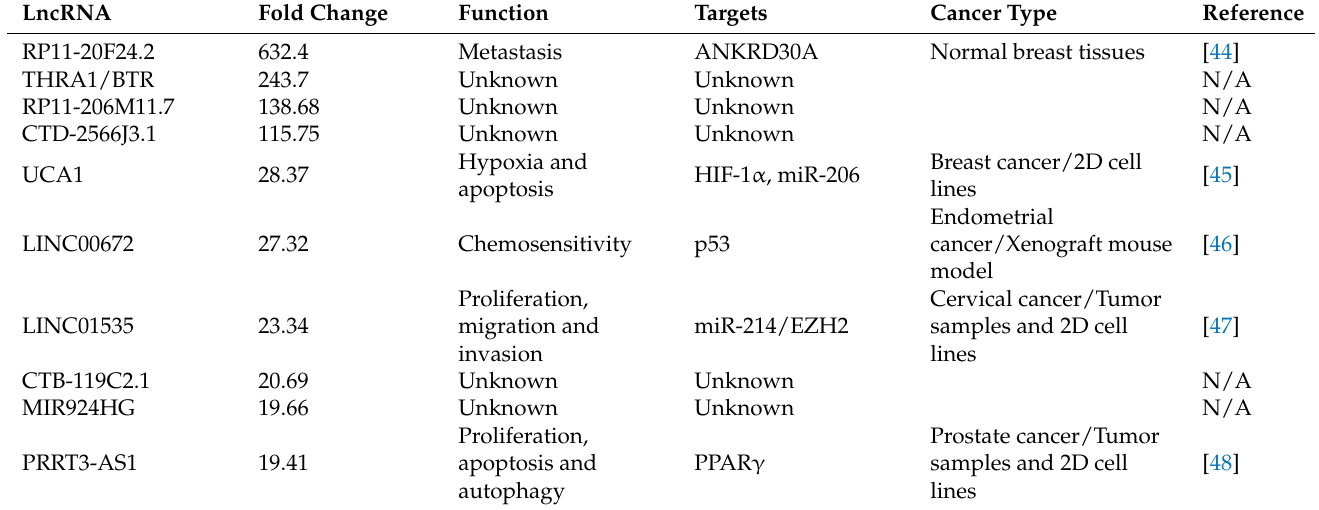
Table 1. Up-regulated lncRNAs in 3D cultures.